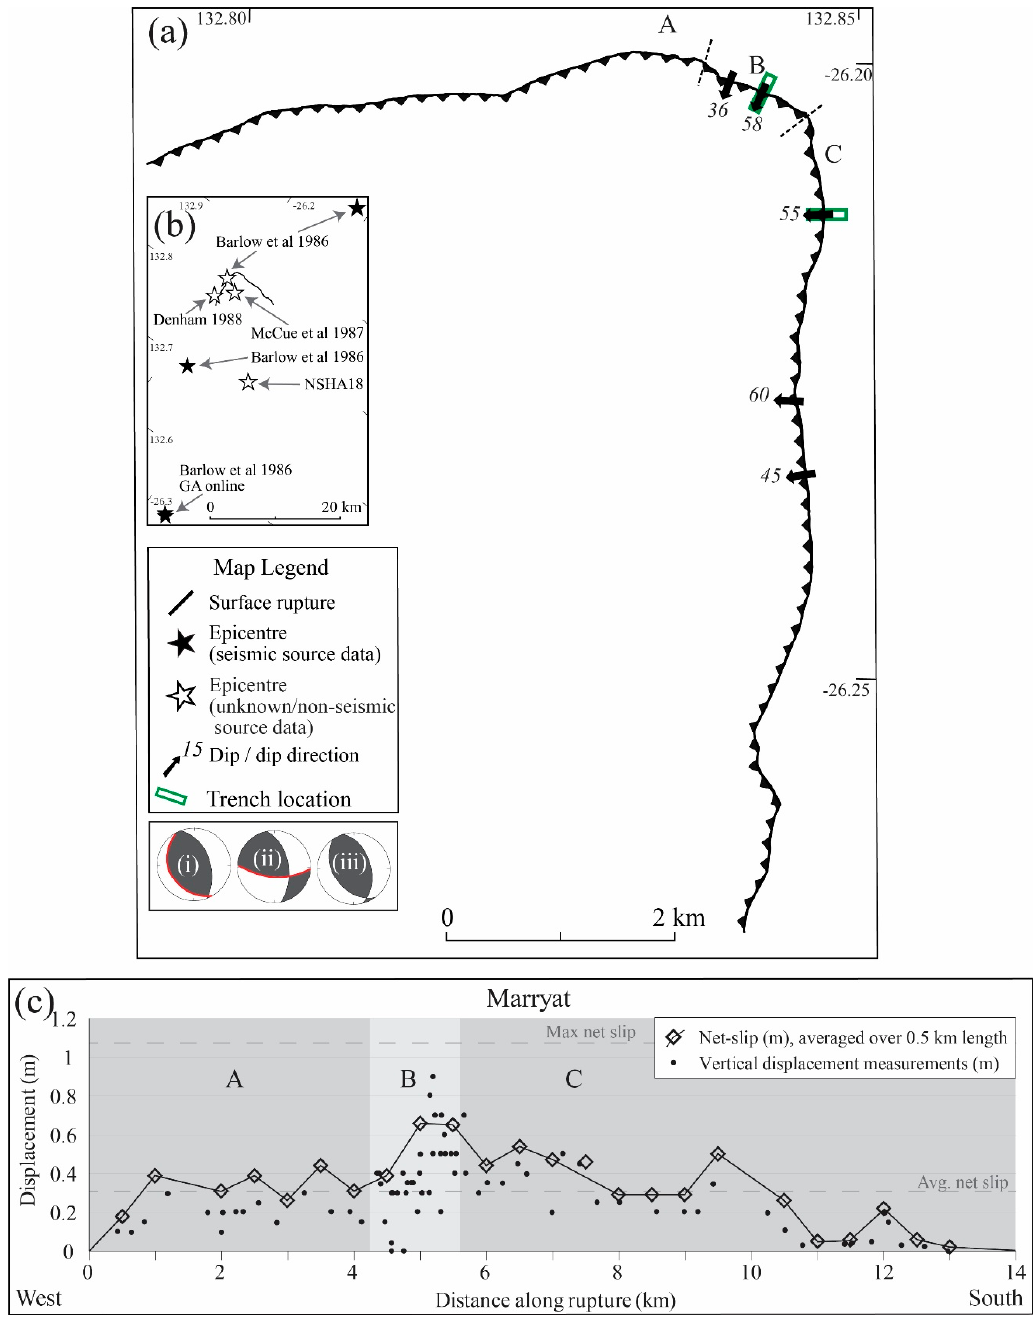
Figure 6. 1986 Mw 5.7 Marryat Creek earthquake ( a ) rupture and fracture map of Marryat Creek scarp and available dip measurements [48,118] with faults labelled as per displacement graphs, focal mechanisms (red line shows preferred plane from original publication) from (i) Fredrich et al., 1968, (ii) Barlow et al., 1986, (iii) CMT, trench location from [118], ( b ) published epicenter locations, and ( c ) graph of along-rupture vertical and lateral displacement measurements [48] and net slip calculated from available data averaged over 0.5 km increments (this study).